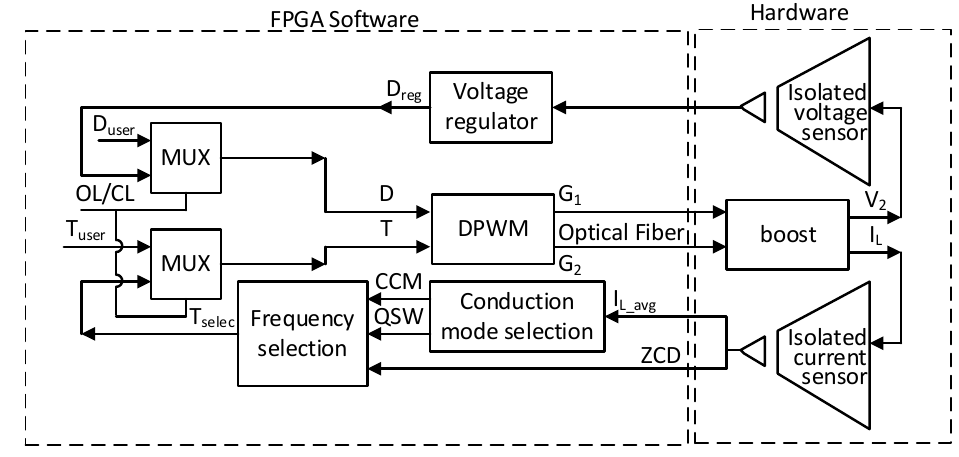
Figure 4. Schematic of the control system implemented.